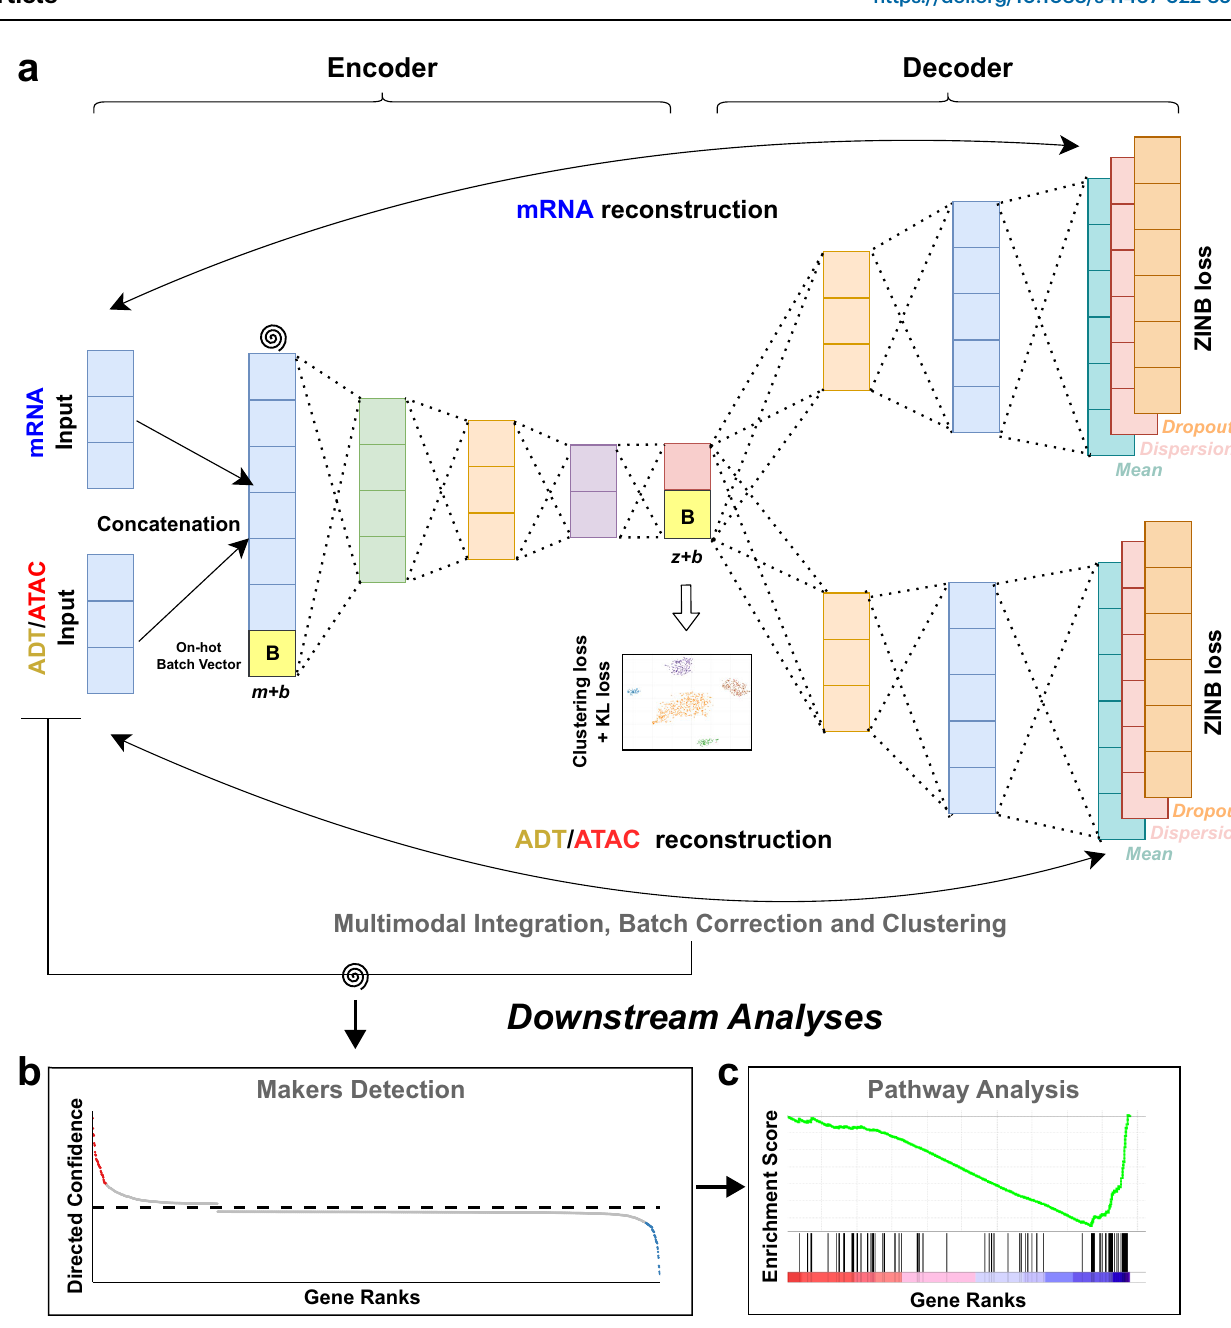
Fig. 1 | The architecture ofscMDC. scMDC has one encoder for the concatenated dataandtwodecodersforeachmodalinthemultimodaldata( a ).Itcanbeusedfor clustering CITE-seq data and 10x Single-Cell Multiome ATAC + Gene Expression (SMAGE-seq) data. The spiral symbols indicate the arti fi cial noises added to the data. For multi-batch datasets, scMDC will work in a conditional autoencoder manner. A one-hot batch vector B (in dimension b ) will be concatenated to the input feature of the encoder (with raw feature dimension, m ) and the decoders batch effects when analyzing multi-batch data. To our knowledge, scMDC is the fi rst end-to-end deep clustering method that can both integrate multimodal data and remove the batch effect for different types of multimodal data. The superior performance of scMDC is observed from the extensive experiments on both CITE-seq and SMAGE-seqdata.Afterclustering,foragivencluster,wealsodetectthe markers(genesorproteins)bytransplantinganACEmodel 35 toscMDC